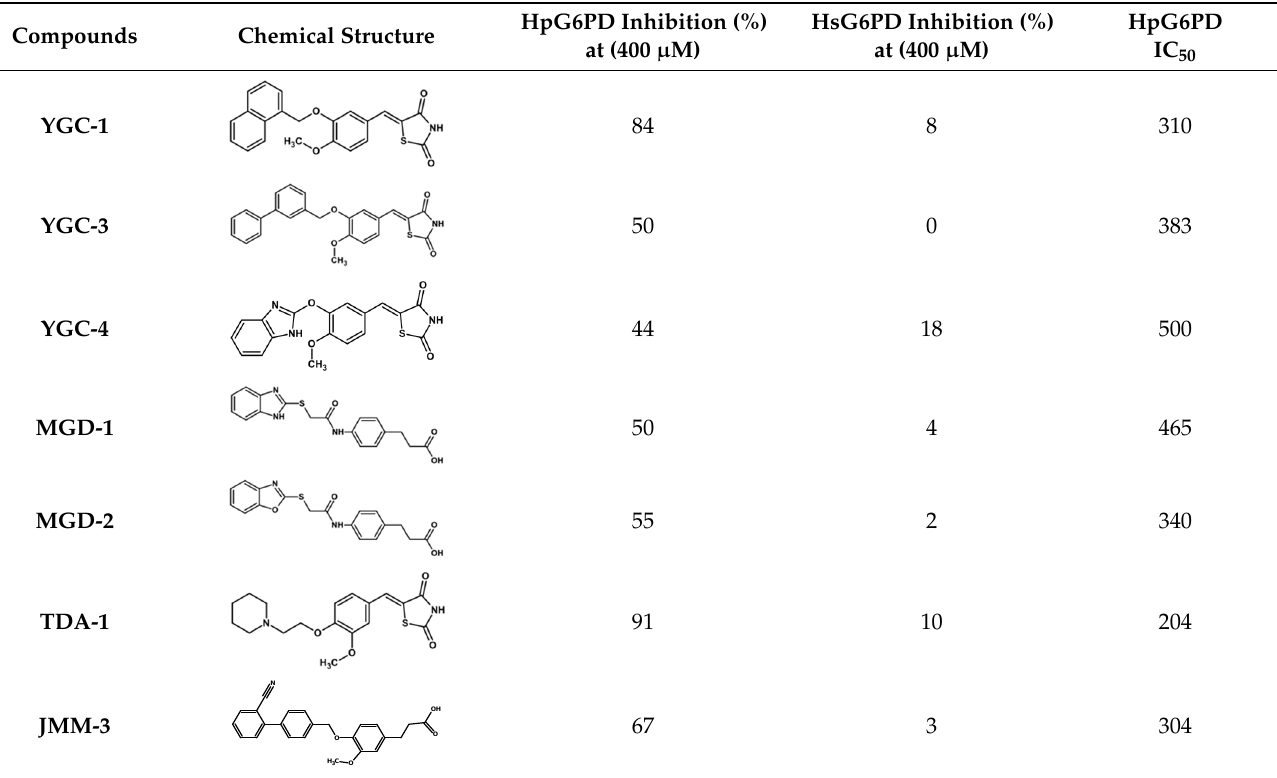
Table 1. Compounds showing an inhibition more significant than 40% in the HpG6PD enzyme at a final concentration of 400 μ M.